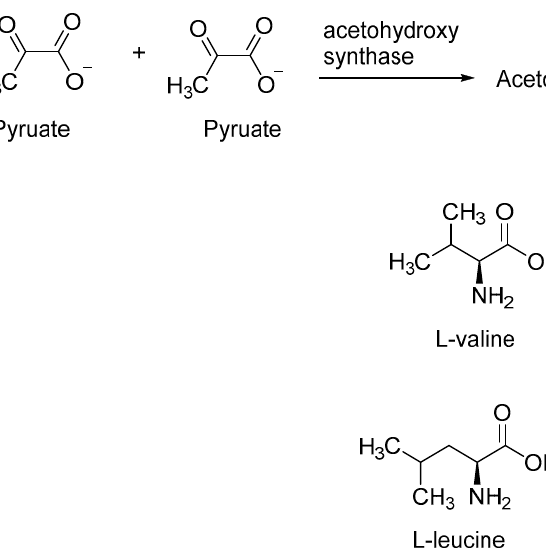
Figure 6. Schematic representation of branched chain amino acids in bacteria. It shows how two pyruvate molecules (product of glycolysis) in the presence of acetohydroxy acid synthase react to form acetolactate. Isomero ‐ reductase enzyme converts acetolactate into an intermediate called dihydroxyisovalerate which, in the presence of dihydroxy acid dehydratase enzyme, dehydrates and produces the final intermediate, ketoisovalerate. Enzyme transaminase B converts ketoisovalerate into L ‐ valine, while enzyme leu BCD converts it into L ‐ leucine. Concept adopted from Amorim Franco, T.M., 2017 [38] .